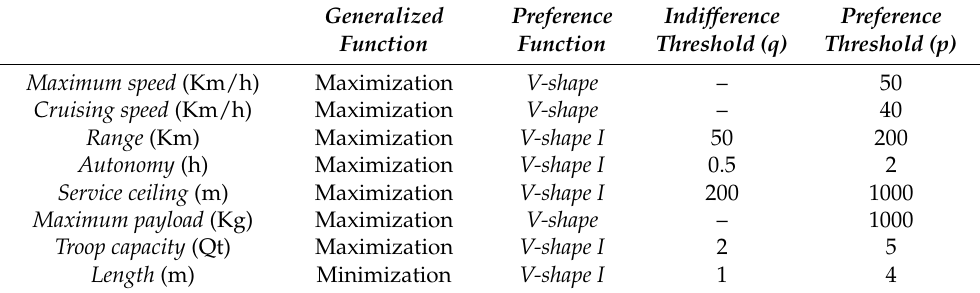
Table 11. Preference function and